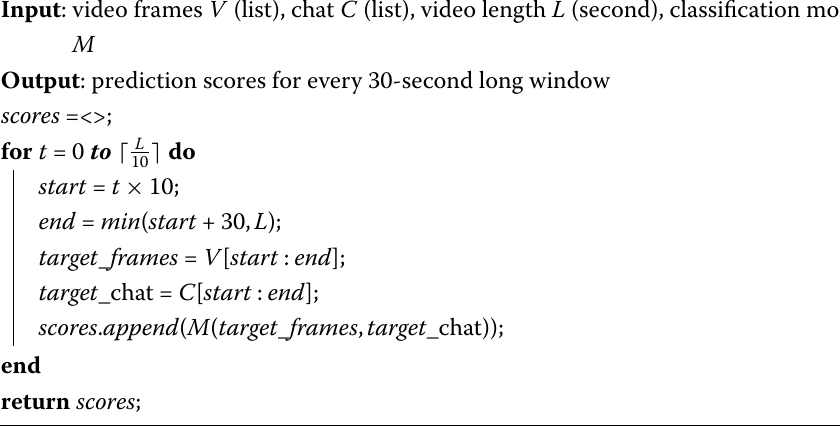
Algorithm 1: Epic moment detection